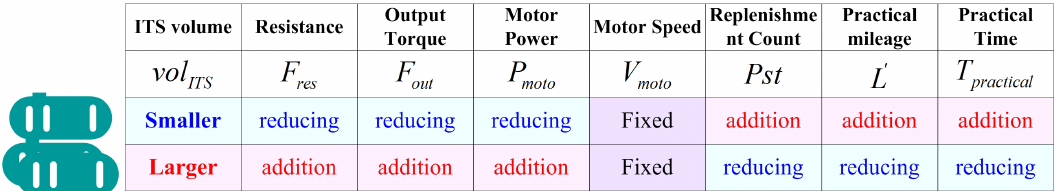
Figure 3. Relationship between main conditions and vol ITS